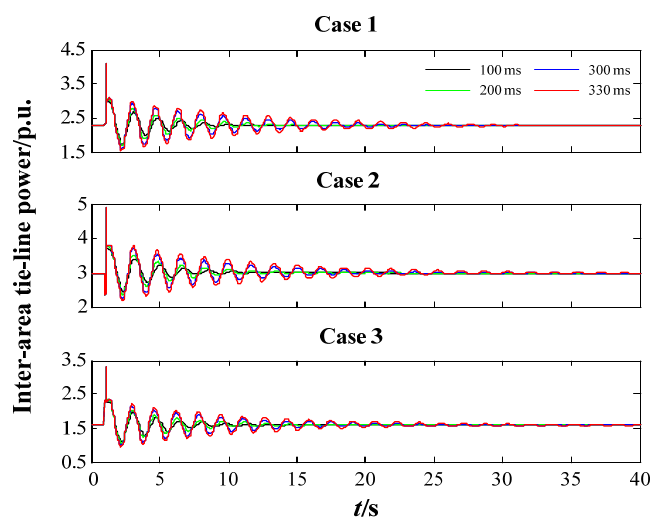
Figure 10. Power oscillation of the tie ‐ line under different delay in three load cases.